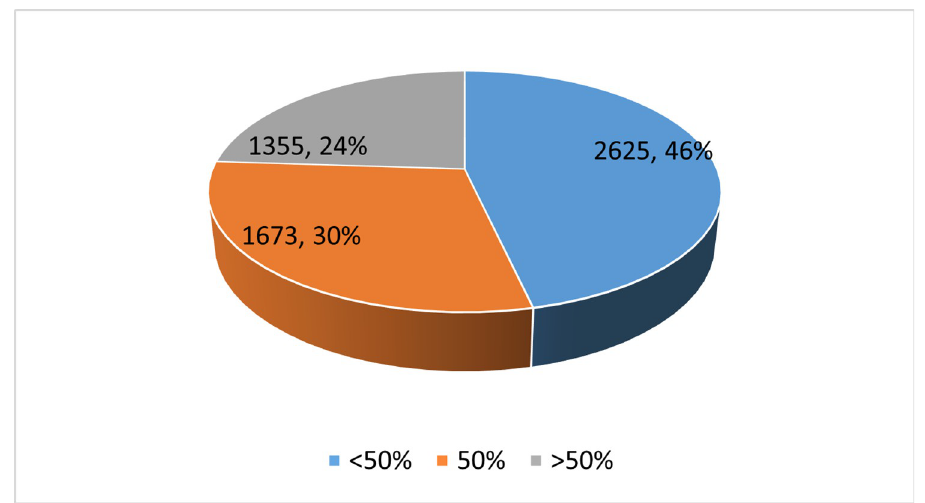
Fig 1. The number and proportion of PPP projects corresponding to the proportion of different operation plans.